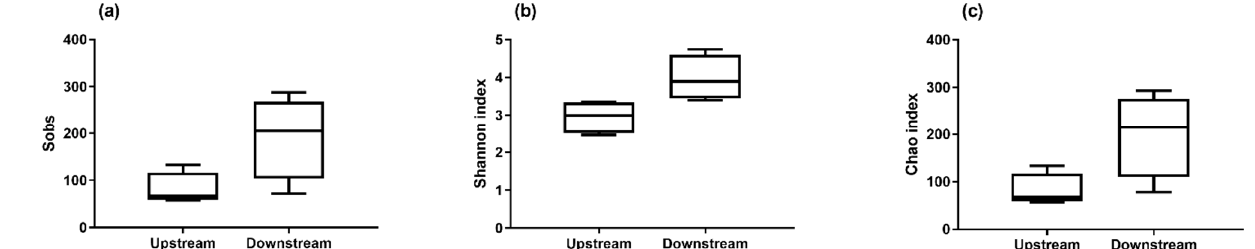
Figure 4. Number of observed OTUs calculated with the Sobs index ( a ), and diversity analysis performed using the Shannon index ( b ) and Chao index ( c ) for air samples collected upstream ( n = 16) and downstream ( n = 10) from the biofilter. Results are presented as the median and box plots (25–75%) with whiskers (10–90%).